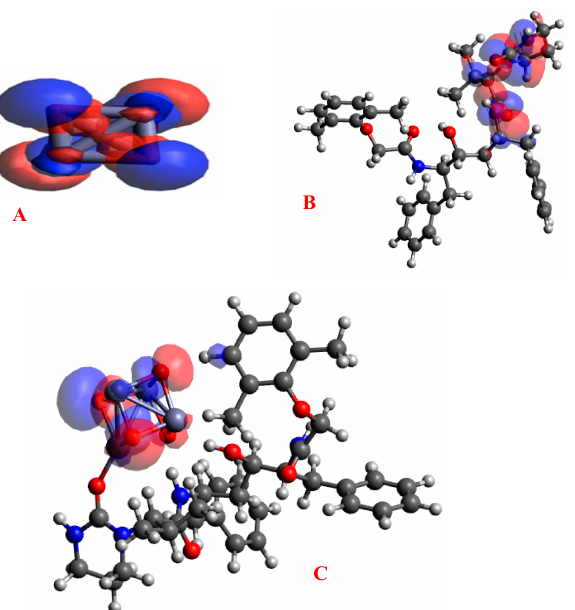
Figure 2. Highest occupied molecular orbitals (HOMO) surfaces for the ( A ) ZnO-NP, ( B ) Lop and ( C ) ZnO-Lop (Isovalue of 0.01).